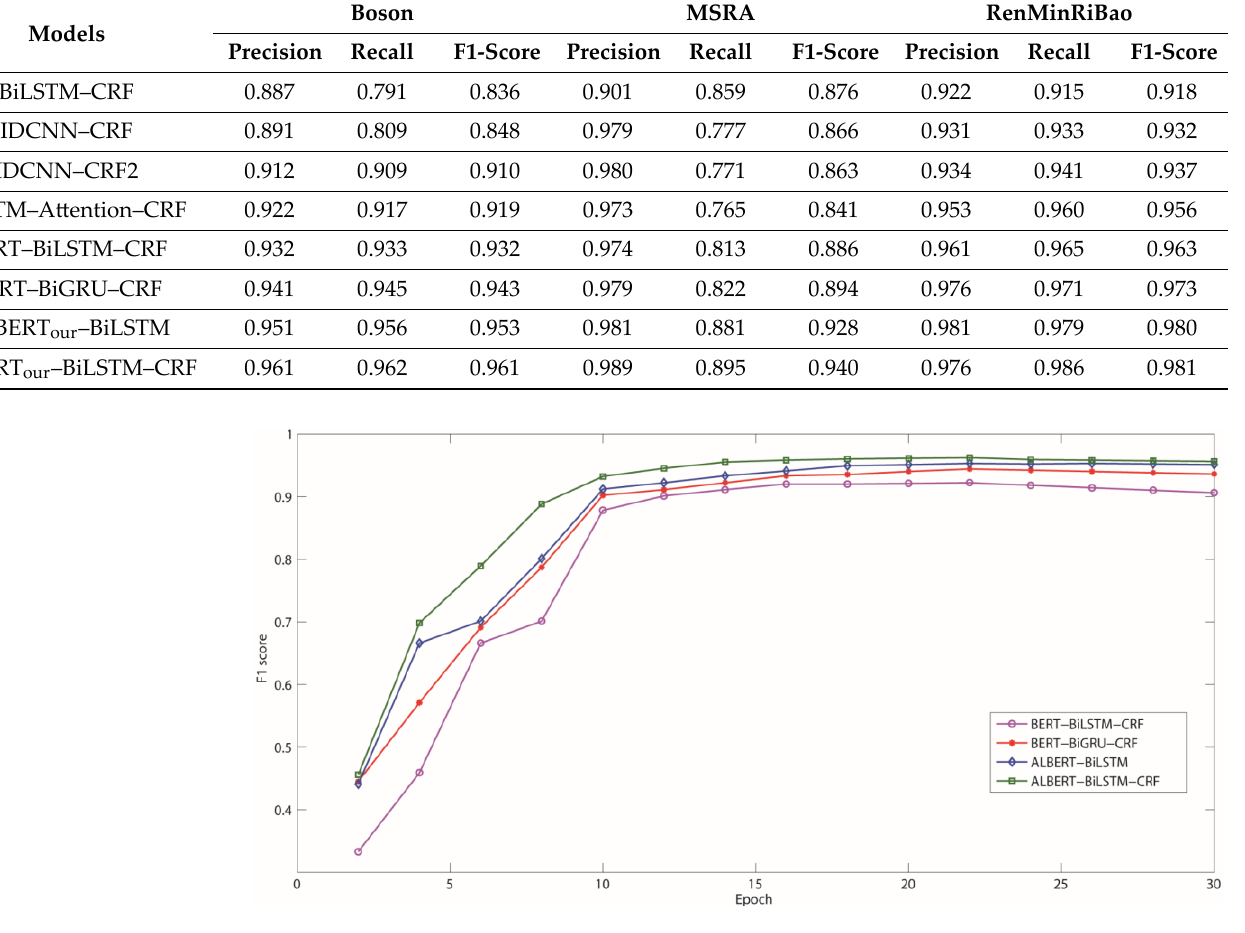
Figure 7. Average F1-score of the presented and baseline NER algorithms with different sizes of labeled data. As seen in Figure 7, when 9000 sentences were used, the proposed algorithm achieved an average F1-score of 96.2%. The BERT – BiLSTM – CRF, BERT – BiGRU – CRF, and ALBERT – BiLSTM (the baseline) only achieved F1-scores of 92.1%, 94.4%, and 95.3%, re- spectively. This shows that the proposed NER algorithm outperforms the baseline. 5.5. Ablation Analysis To verify the effectiveness of pretraining on our approach, we design the following variant models and conduct experiments on the constructed dataset (see Table 12). Table 12. Experimental performance of variant models on the TPCNER dataset. Model